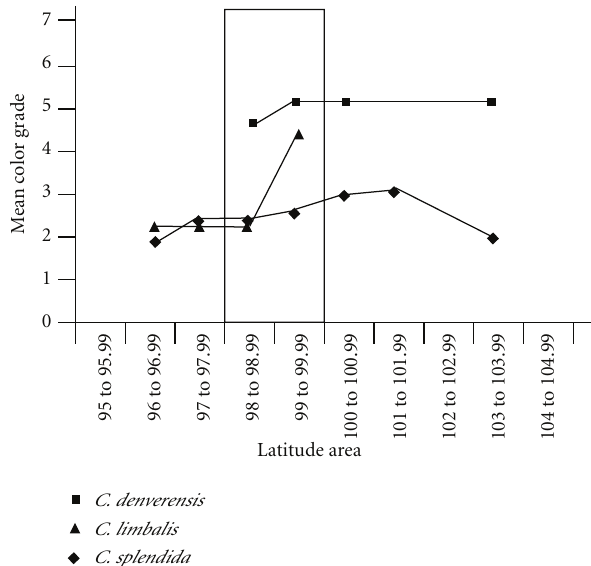
Figure 11: Graph of mean elytral color by code for C. denverensis , C. limbalis , and C. splendida by longitude. Region of character con- vergence for C. denverensis and C. splendida depicted by rectangle.